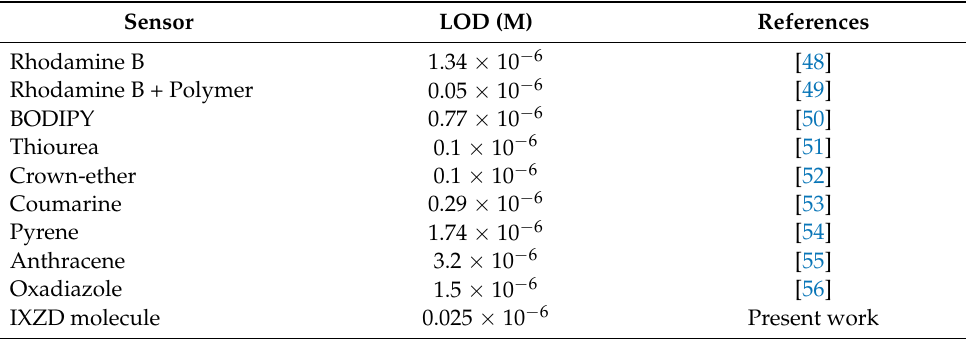
Table 1. Comparison of the IXZD sensor with recently research-based Hg(II) detection. Sensor LOD (M)